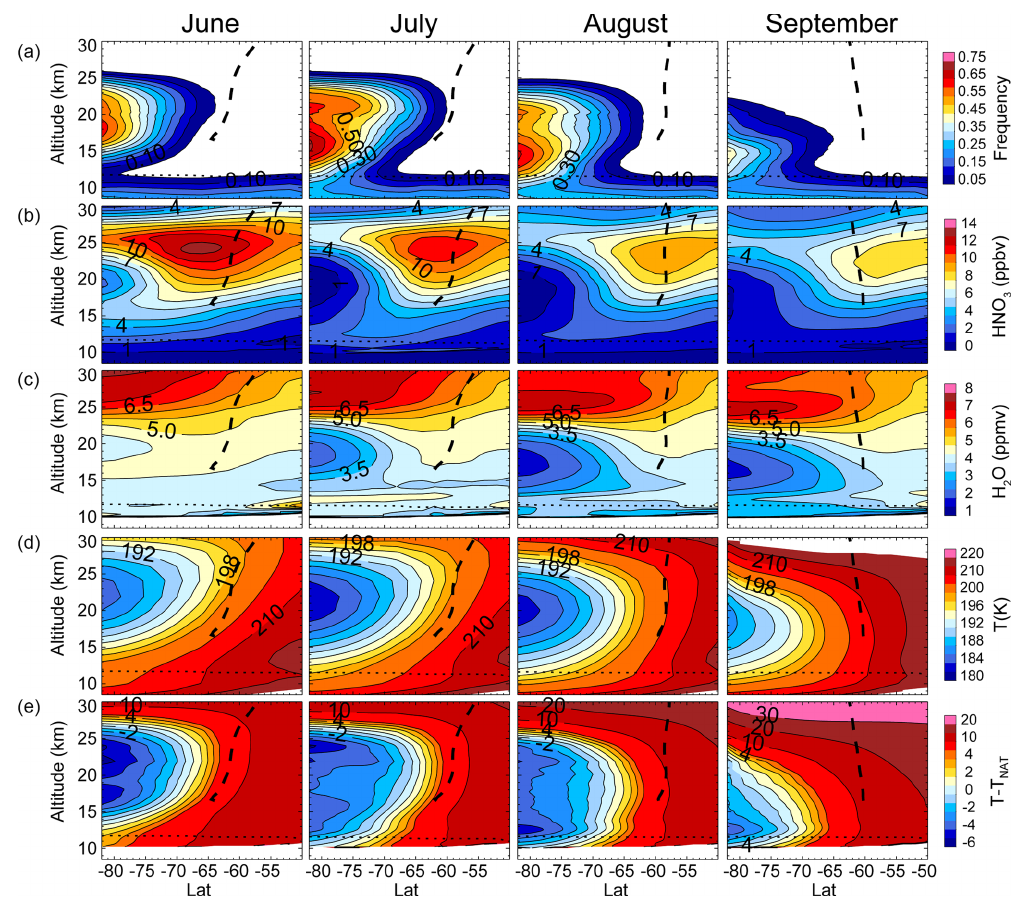
Figure 17. Latitude–altitude cross sections of 12-year average, monthly zonal mean (a) Antarctic PSC occurrence frequency, (b) cloud-free MLS HNO 3 , (c) cloud-free MLS H 2 O, (d) MERRA-2 temperature, and (e) T − T NAT . For reference, the mean location of the vortex edge (heavy dashed line) and MERRA-2 tropopause height (dotted line) are indicated in the panels.